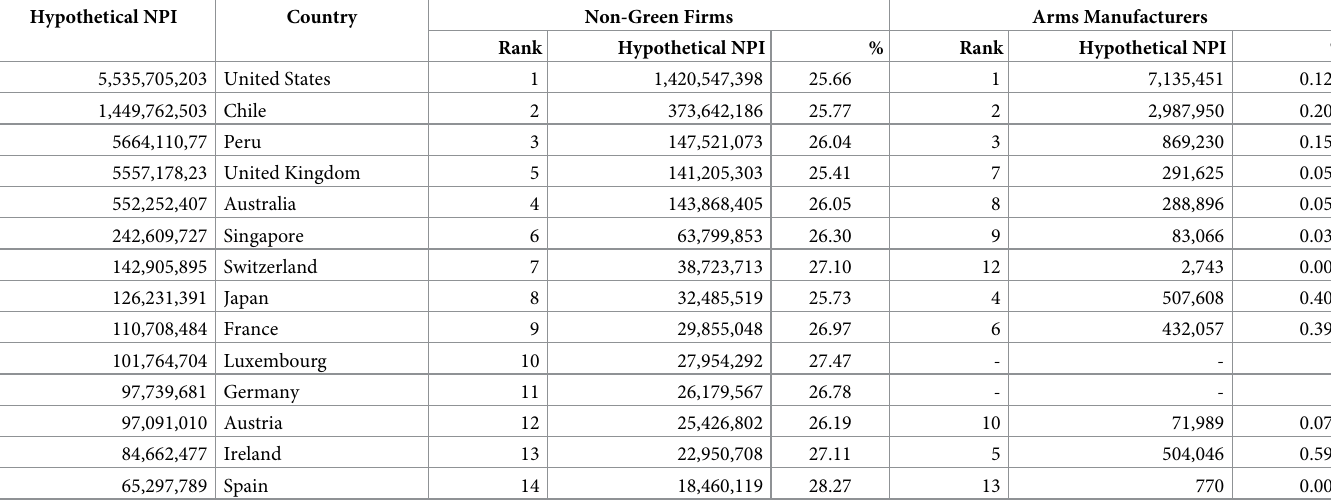
Table 7. National influence of the equity funds on non-ESG firms. Hypothetical